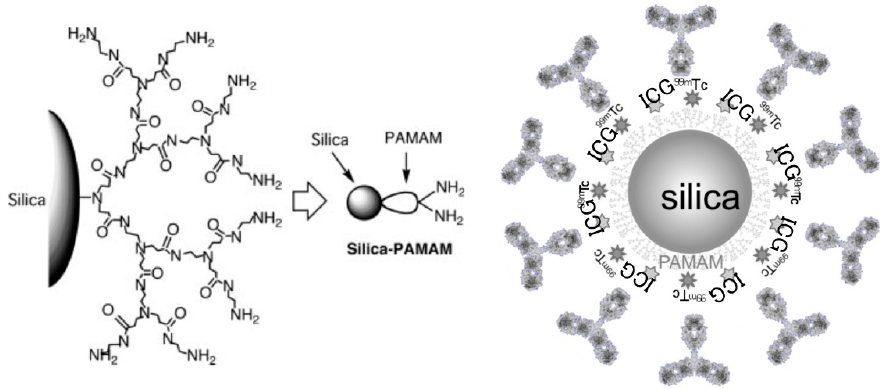
Figure 12. Dual-imaging probe (dual-labeled near-infrared/ 99m Tc imaging probe using PAMAM-coated Figure silica nanoparticle).